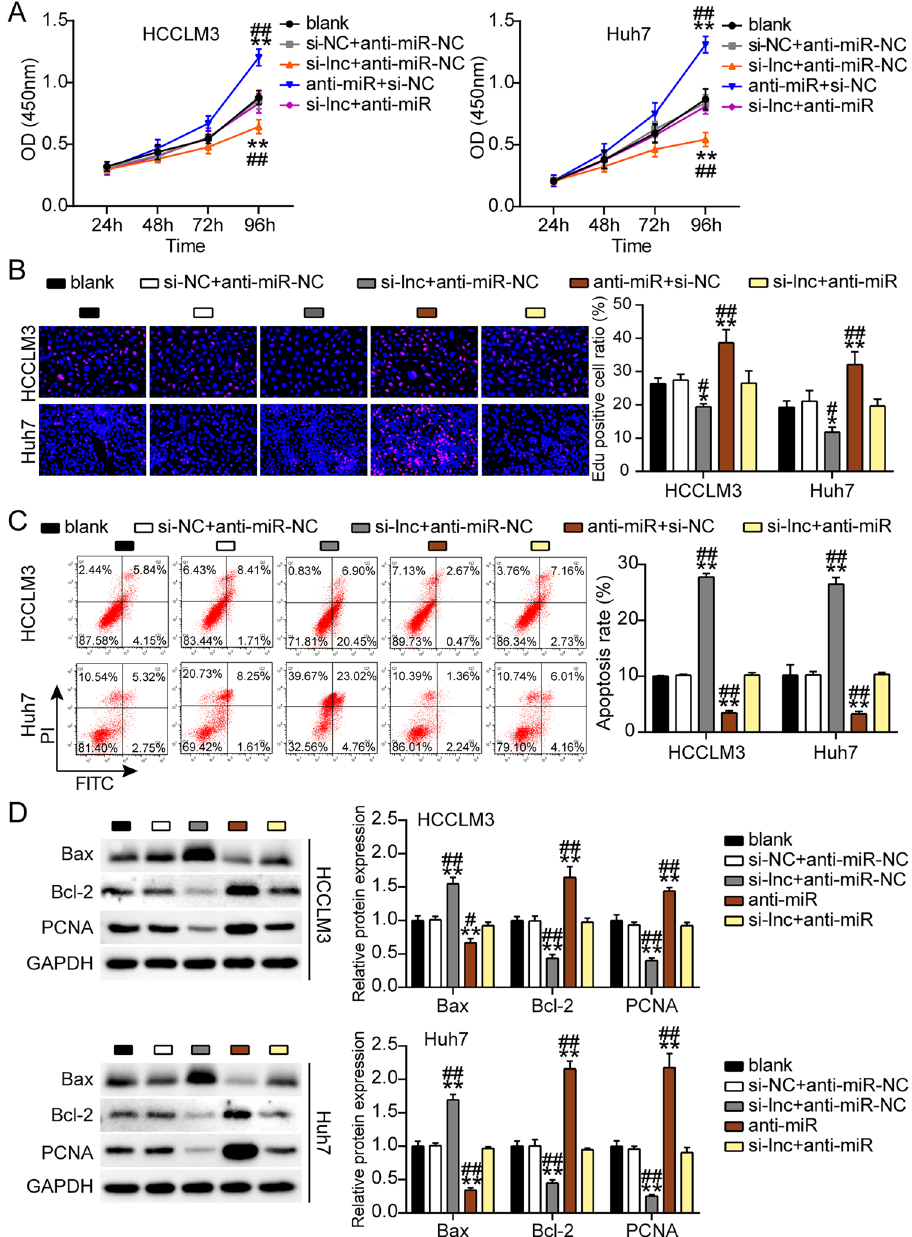
Figure 6. ST8SIA6-AS1 sponging miR-142-3p facilitated the development of LIHC cells. ( A ) Cell viability determination with CCK8 assay. ( B ) Proliferation of cell was determined by EdU assay. ( C ) Apoptosis of cell determination by FITC apoptosis detection kit. ( D ) Bax, Bcl-2 and PCNA protein expression were detected using western bloting assay. # P < 0.05, ## P < 0.001 compared with si-lnc + anti-miR; *P < 0.05, **P < 0.001 compared with blank. NC: negative control; blank: blank control; anti-miR: miR-142-3p inhibitor; Si-lnc: SiRNA-ST8SIA6-AS1; Si-lnc + anti-miR: SiRNA-ST8SIA6-AS1 + miR-142-3p